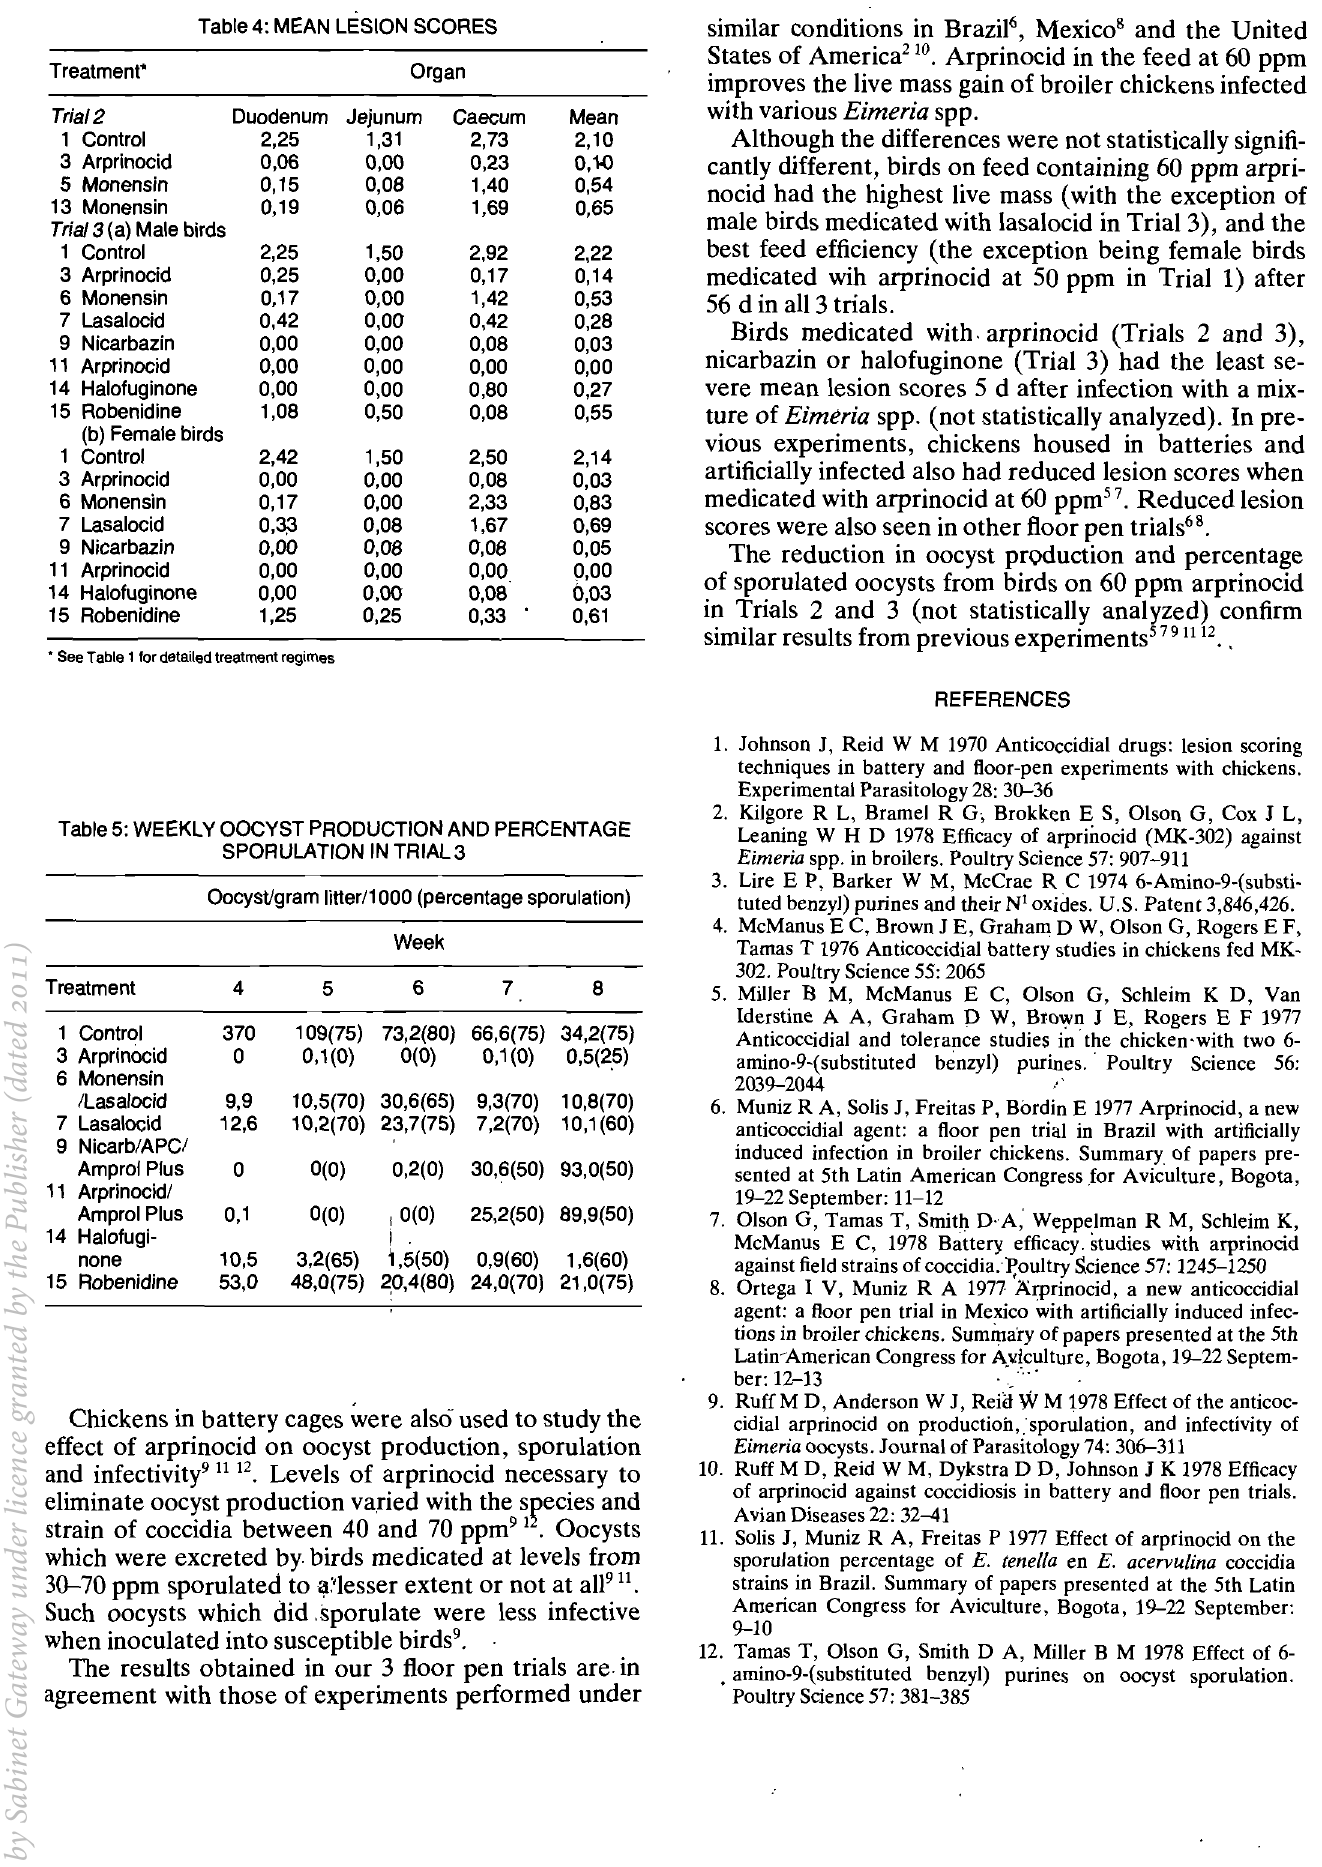
similar conditions in Brazil6, Mexicos and the United Table 4: MEAN LESION SCORES States of America 2 10, Arprinocid in the feed at 60 ppm Treatment' Organ improves the live mass gain of broiler chickens infected with various Eimeria spp, Tria/2 Although the differences were not statistically signifi cantly different, birds on feed containing 60 ppm arpri nodd had the highest live mass (with the exception of male birds medicated with lasalocid in Trial 3), and the best feed efficiency (the exception being female birds medicated wih arprinocid at 50 ppm in Trial 1) after 56 d in all 3 trials. Birds medicated with. arprinocid (Trials 2 and 3), nicarbazin or halofuginone (Trial 3) had the least se vere mean lesion scores 5 d after infection with a mix ture of Eimeria spp. (not statistically analyzed), In pre vious experiments, chickens housed in batteries and artificially infected also had reduced lesion scores when medicated with arprinocid at 60 ppm 57 . Reduced lesion scores were also seen in other floor pen trials 68 , The reduction in oocyst production and percentage of sporulated oocysts from birds on 60 ppm arprinocid in Trials 2 and 3 (not statistically analyzed) confirm similar results from previous experiments 5 7 91112. • See Table 1 lor detailed treatment regimes